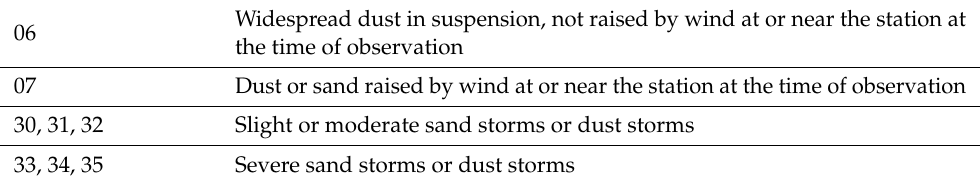
Table 2. The dust-related codes that are used in this